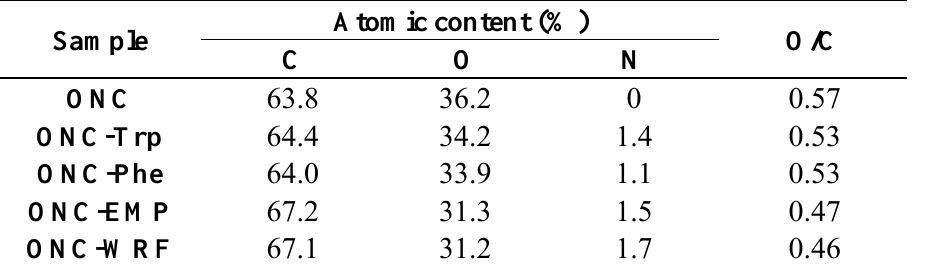
Table 3. Experimental atomic composition and O/C ratio obtained by XPS analysis for ONC, ONC-Trp, ONC-Phe, ONC-EMP, and ONC-WRF. Errors in determination ±